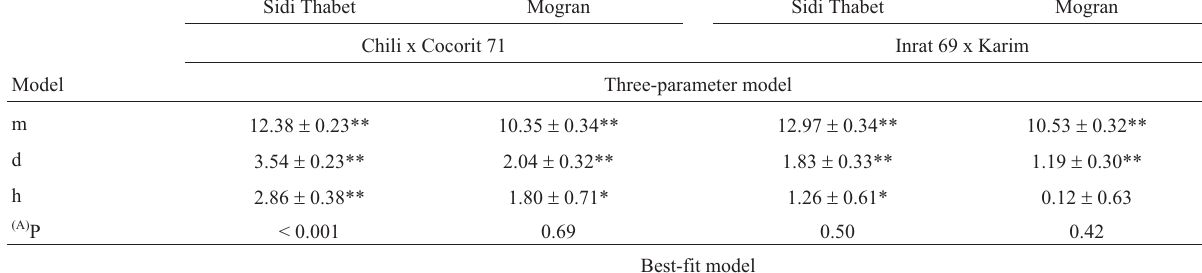
Table 2 - Estimates of gene effects (cid:2) SE for grain protein content in four crosses (Chili x Cocorit 71, Inrat 69 x Karim, Inrat 69 x Cocorit 71, and Chili x Karim) at two sites (Mogran and Sidi Thabet), with two replications. Sidi